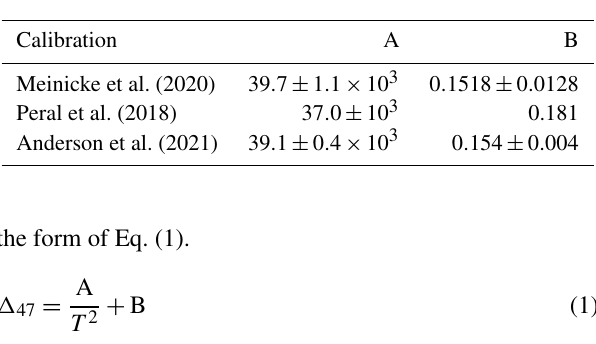
Table 1. Clumped-isotope paleothermometry calibration parame- ters for Eq. (1), using the I-CDES 90 ◦ C scale. The A and B pa- rameters of the Meinicke et al. (2020) calibration were recalculated from the CDES to the I-CDES 90 ◦ C framework by Meinicke et al. (2021). The Peral et al. (2018) calibration parameters were re- calculated by Peral et al. (2022). The reader is referred to Peral et al. (2022) for more information on the uncertainty on this cal- ibration. A recalculation of the Anderson et al. (2021) calibration was not necessary, as they have been originally defined in the I- CDES 90 ◦ C framework. Reported uncertainties refer to ±